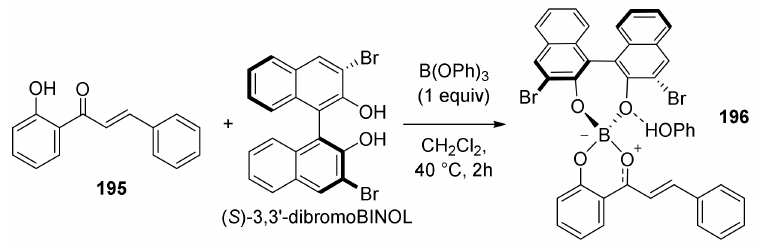
Figure 65. Borate chiral complex with model dienophile 195